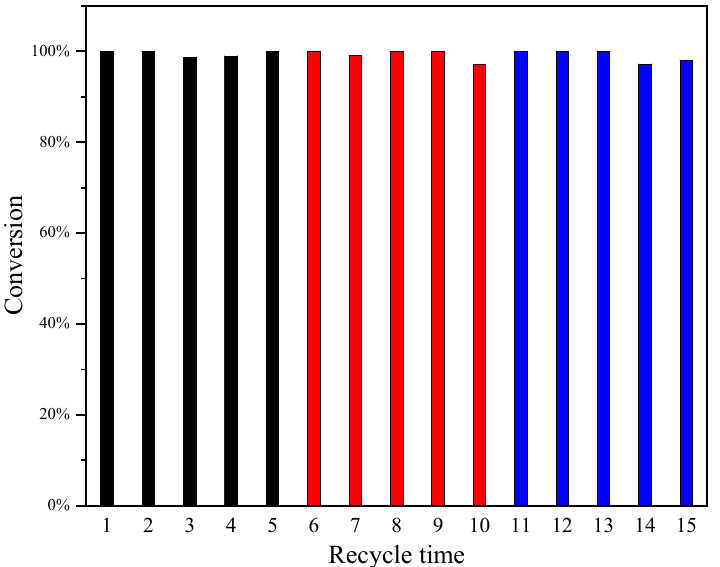
Figure 4. Black: benzonitrile. Red: nitrobenzene. Blue: benzaldehyde. The reaction condition: 10 mmol reagent, 100 mg catalyst, 120 °C 4.0 MPa H 2 . When the loss of catalyst reached 20%, the catalyst was replenished, and replenishment was carried out at the 7th and 12th recycles. Table 7. The comparison between two catalysts.